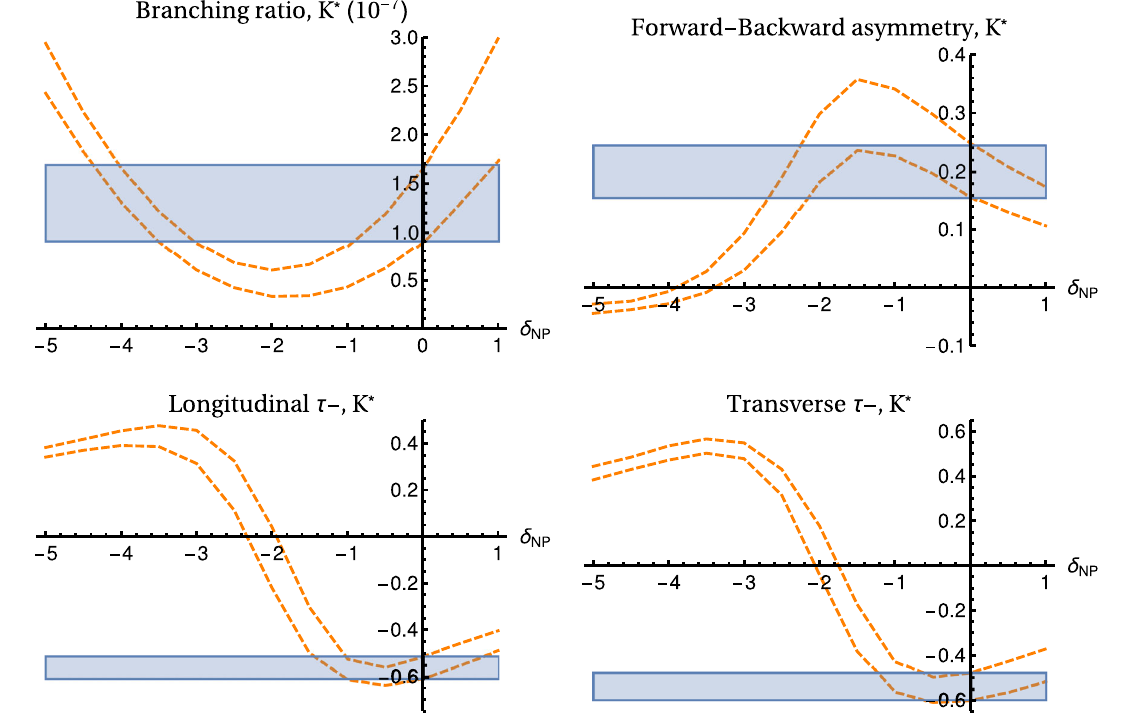
≡ δ NP , whose values are given in the horizontal axes. See Fig. 4 for more comments 9